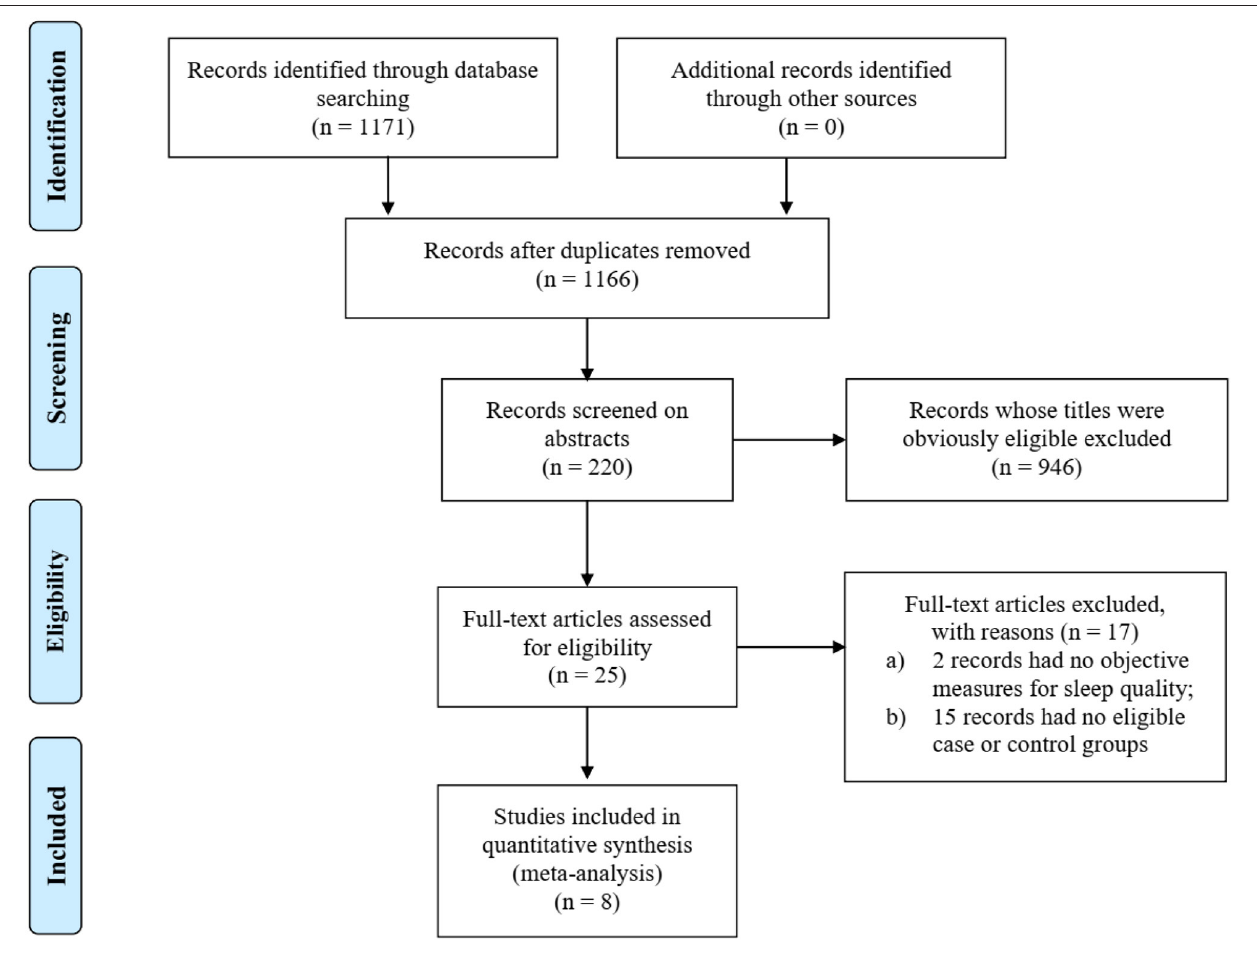
FIGURE 1 | PRISMA flowchart of searching and selection guidelines. TABLE 1 | Results of NOS quality assessment of the eight included